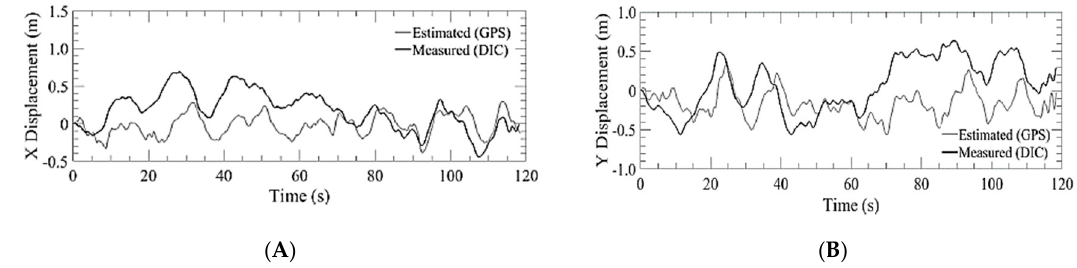
Figure 15. Lateral displacement estimated by GPS of the bridge inspection airframe versus the measured value of the DIC for run 3 where: ( A ) X displacement; ( B ) Y displacement.